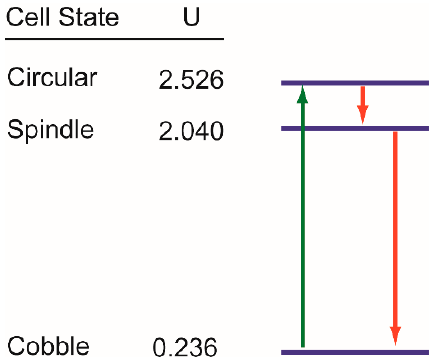
Figure 8. State diagram to understand state transition dynamics. Each morphological state corresponds to a specific discrete energy level in this diagram. These energy levels are shown by blue horizontal lines. Corresponding potentials (U) were calculated from the steady-state population distribution of cells in different states. State transitions are probabilistic and only the dominant state transition paths are shown here using green and red lines. All these state transitions were observed within 60 h of observations in cells treated with 10 ng/mL of EGF.